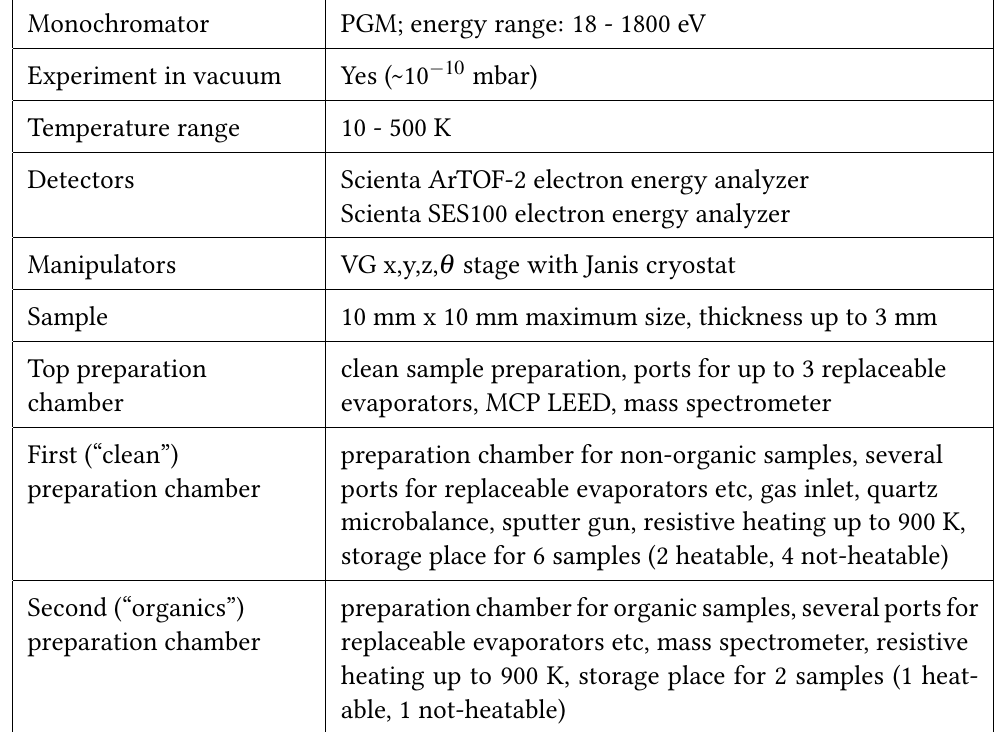
Table 1: Technical parameters of the LowDose PES end